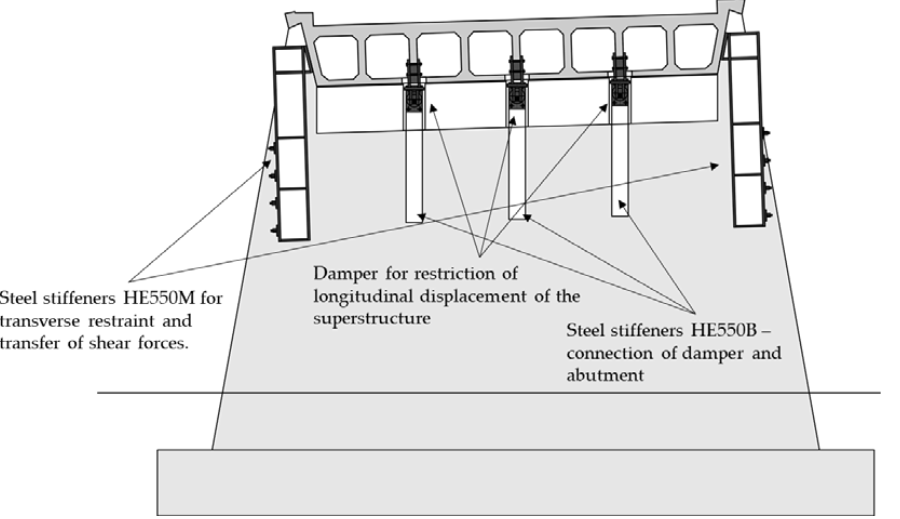
Figure 12. Transverse view of the abutment with both longitudinal and transverse stiffeners and displacement restraints, proposal for seismic retrofitting of the first Case Study bridge.